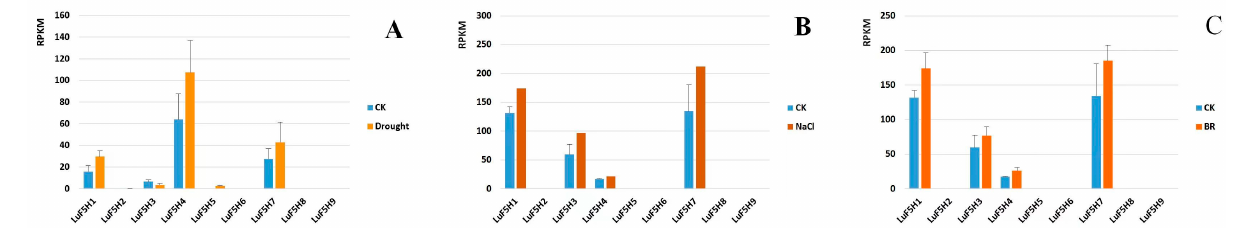
Figure 8. Expression patterns of LuF5H genes in response to various abiotic stresses: ( A ) drought treatment; ( B ) NaCl treatment; and ( C ) BR treatment. The data were obtained from the RNA-seq data (RPKM). The average expression value was calculated by repeated calculations of three independent replicates.